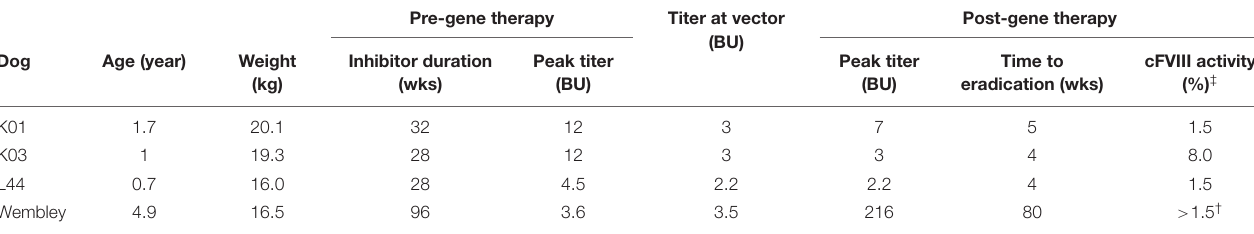
TABLE 2 | Summary of inhibitor eradication in hemophilia A dogs following cFVIII AAV liver-directed gene therapy.